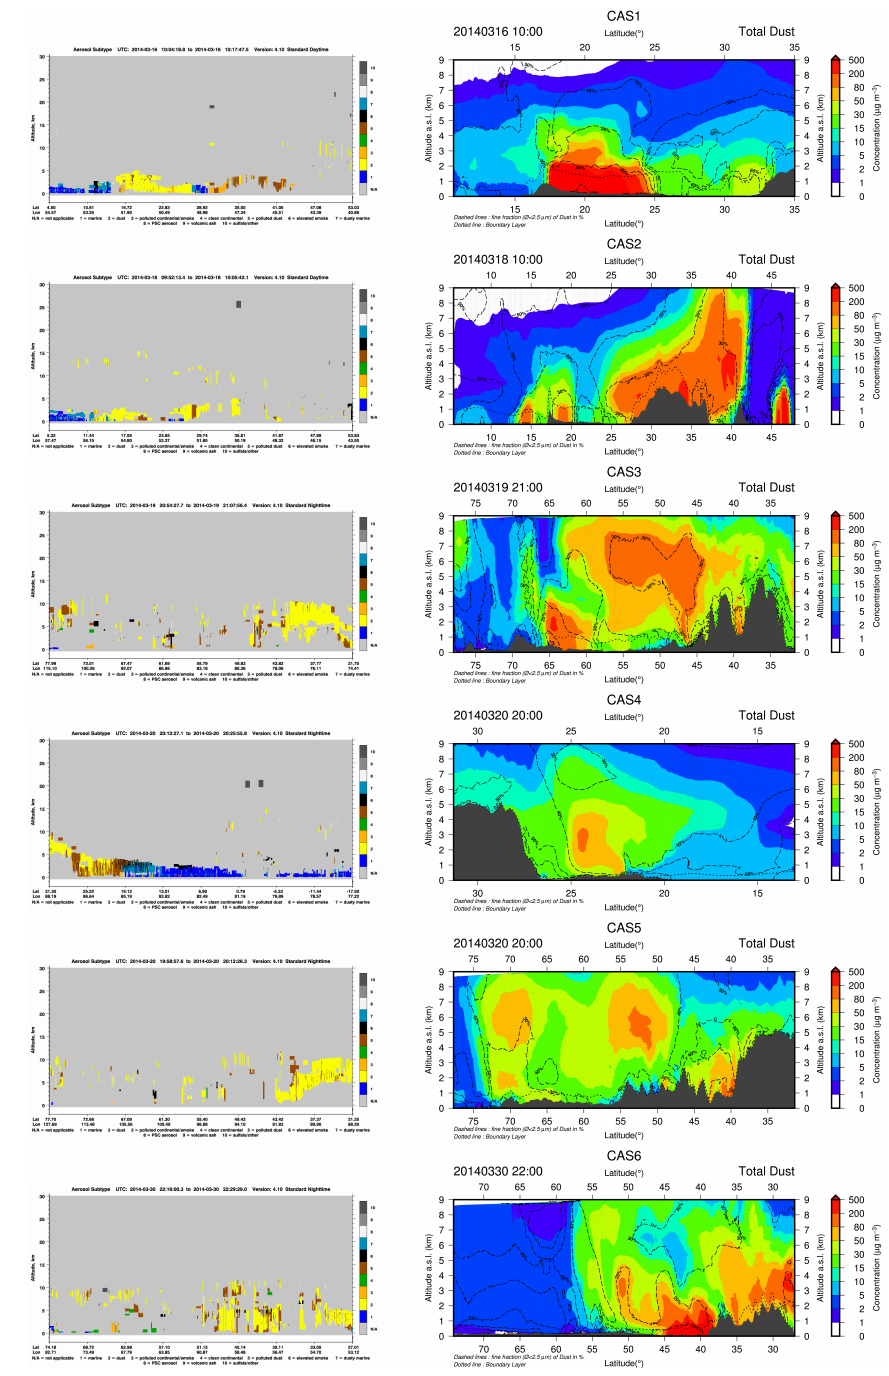
Figure 22. Cross section of CHIMERE dust concentrations ( right ) for various dates zoomed over the highest values area versus the corresponding CALIOP-CALIPSO qualitative data ( left ) showing in yellow the dust load and in orange the polluted dust, for the CALIPSO trajectory from top to bottom respectively, CAS1, CAS2, CAS3, CAS4, CAS5 and CAS6 as reported in Figure 2. The dotted line represents the height of the boundary layer, the dashed lines represent the fraction of fine dust in